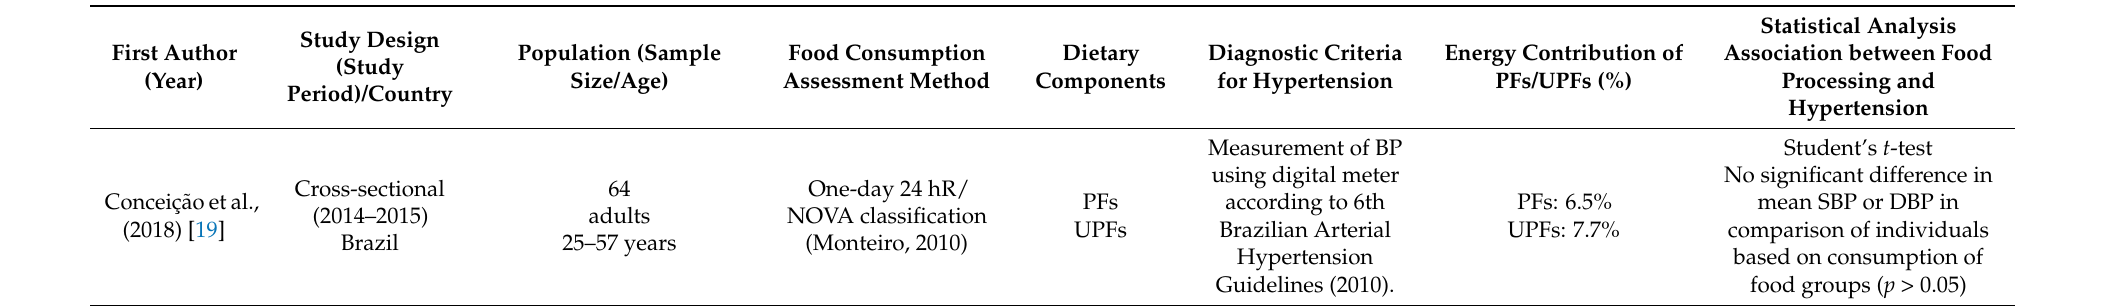
Table 2. Characteristics of studies selected for present review ( n =